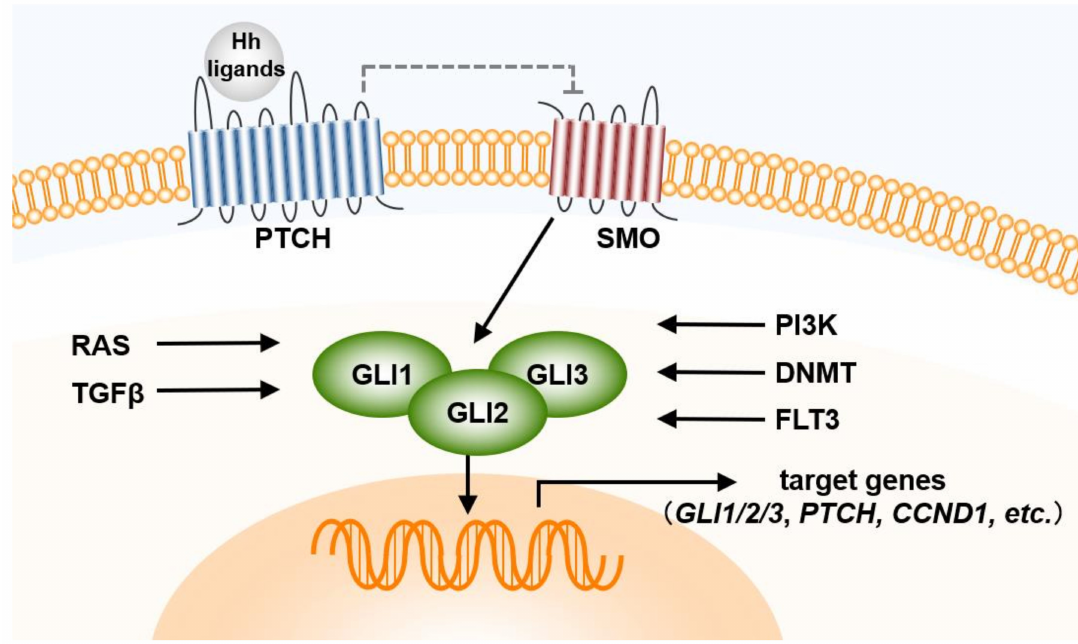
Figure 1. Hh pathway in AML cells. CCND, cyclin D; DNMT, deoxyribonucleic acid methyltransferase; FLT3, FMS-like tyrosine kinase 3; GLI, Glioma; Hh, Hedgehog; PI3K, phosphoinositide 3-kinase; PTCH, Patched; RAS, Rat sarcoma; SMO, Smoothened; TGF, transforming growth